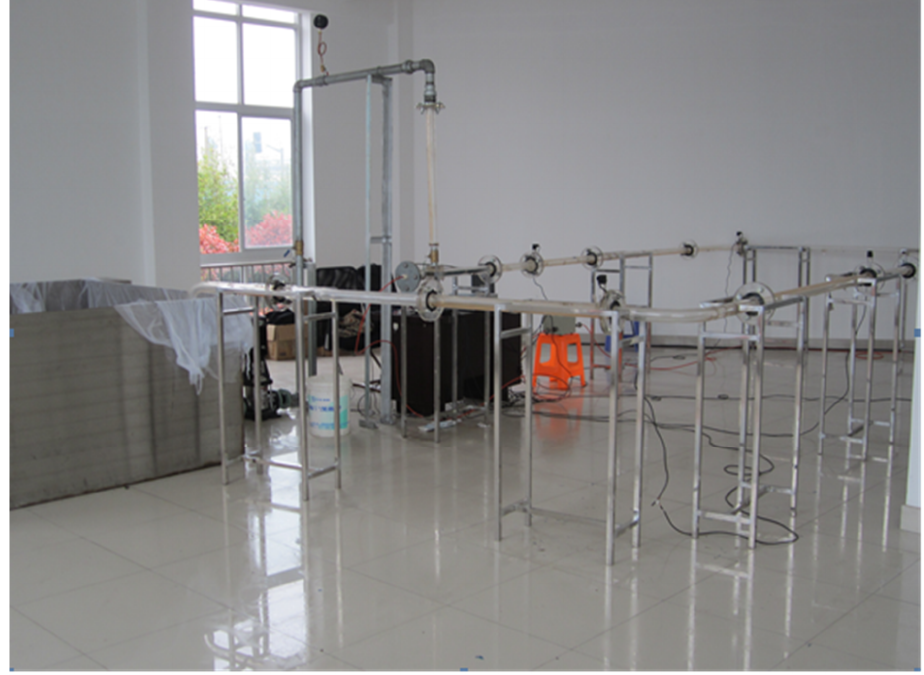
Figure 2. The photo of experimental setup in the laboratory.